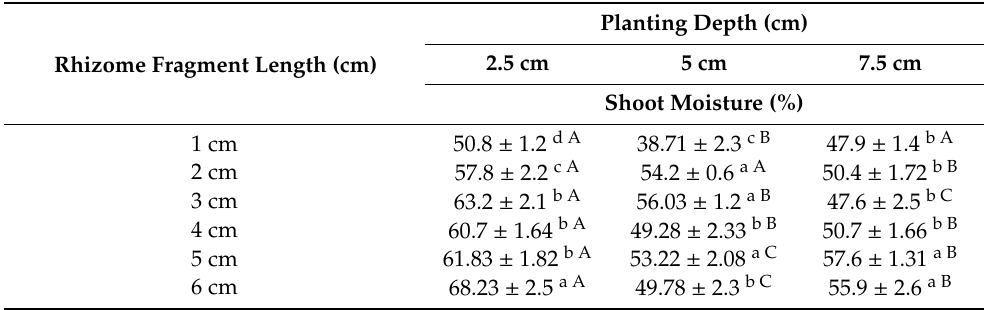
Table 5. E ff ect of planting depth and fragment length on the shoot moisture content of cultivated A. amatymbica